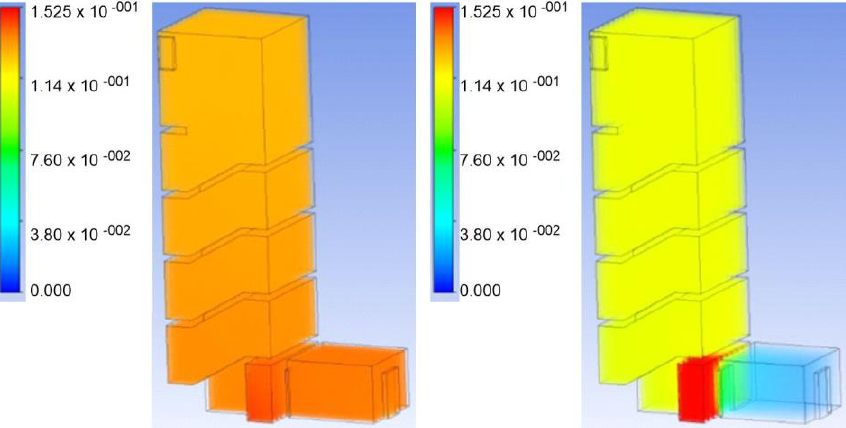
Figure 9. Carbon dioxide distribution for a closed building ( left ) and after the window was opened ( right ). Carbon dioxide was measured as a mass fraction.